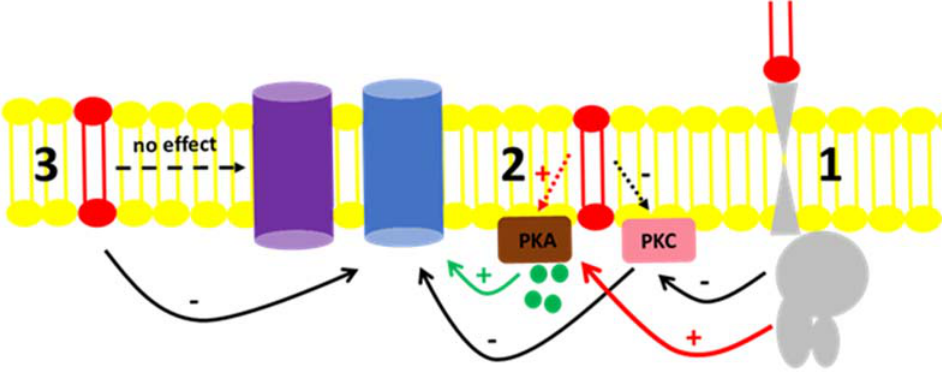
Figure 6. Proposed mechanism for the C1P action on the Na + -ATPase activity from BLM. ( 1 ) C1P (red lipid) inhibits PKC through a yet unknown G-protein coupled receptor, resulting in the inhibition of the Na + -ATPase (blue protein). The same route could activate BLM PKA (red arrow) with no effect on the pump. ( 2 ) C1P could directly bind to effectors present in the BLM, such as the PKC, leading to the inhibitory action on the Na + -ATPase activity described. Our results showed that although PKA is present in the BLM and ready to modulate the pump by cAMP (green circles and green arrow), its activation by C1P had no effect in the pump (red dashed arrow). ( 3 ) C1P directly binds to the Na + -ATPase or is enriched in the lipidic membrane microenvironment surrounding the Na + -ATPase, thus modulating it. From the results presented here, we were not able to detect any modulatory action of C1P on the Na + /K + -ATPase (purple protein) present in the BLM fractions. In the present work, we show that C1P inhibited the Na + -ATPase activity (C1P 50 = 10 nM) (Figure 1), while it had no effect on the Na + +K + -ATPase resident in the